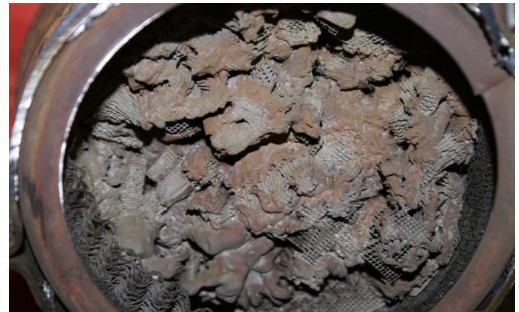
Figure 2. A catalytic converter with an irreversible change in the internal cells of the catalytic